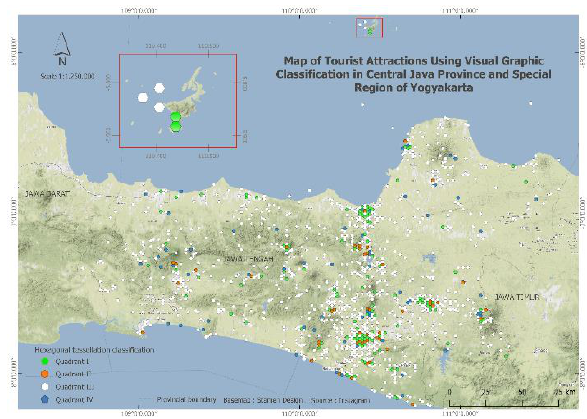
Figure 4.5 Map of tourist attractions using graphic classification Hexagonal tessellation geovisualization uses visual graphic classification in the form of area. All of the tourist attractions are represented in each tessellation cell despite it being many. supported with statistic data of tourist attractions. Figure 4.5